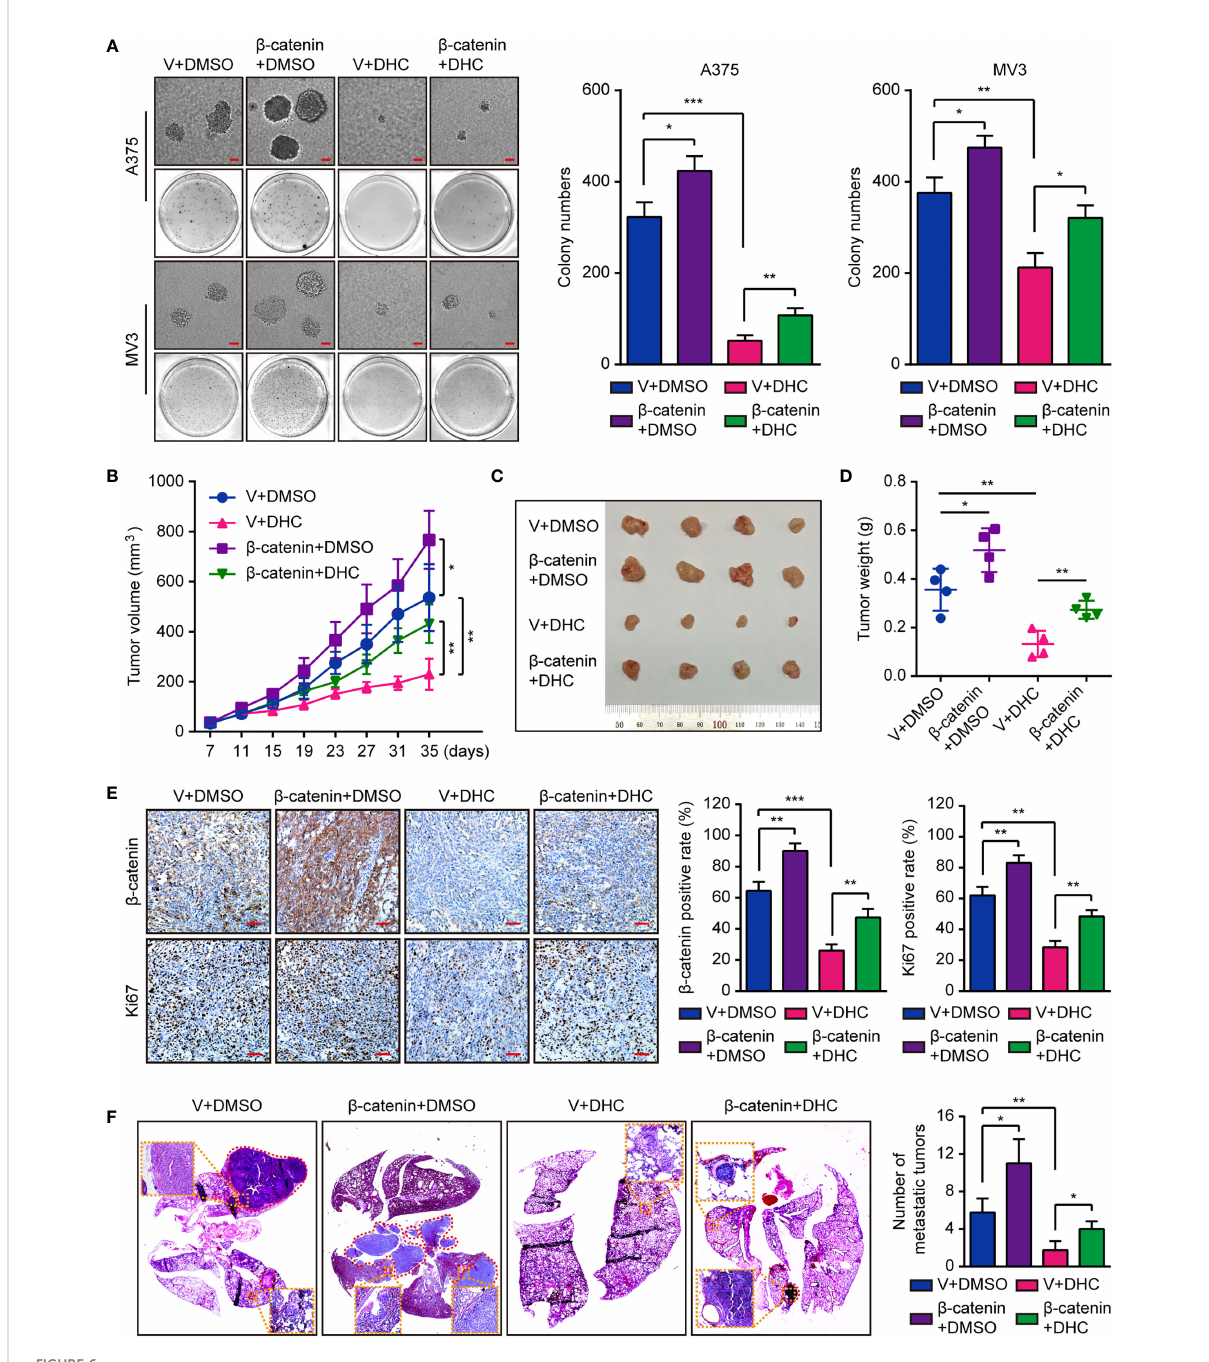
FIGURE 6 Overexpression of b -catenin retrieves DHC-induced inhibition of tumor growth and pulmonary metastasis of melanoma cells. (A) Colonies generated by b -catenin/vector overexpressed A375 and MV3 cells after treatment with 100 m M DHC for 3 weeks. Scale bar, 1 mm. (B) Tumor volume of b -catenin/vector overexpressed A375 xenograft tumors in mice after treatment with DHC (20 mg/kg/day for 28 days) and DMSO. (C, D) The tumors in mice were excised and weighed. (E) IHC of b -catenin and Ki67 in the xenograft tumors. Scale bar, 100 m m. (F) H&E staining of the lungs from b -catenin/vector overexpressed A375 metastasis mice model after treatment with DHC (20 mg/kg/day for 45 days) and DMSO. * P <0.05; ** P <0.01; *** P <